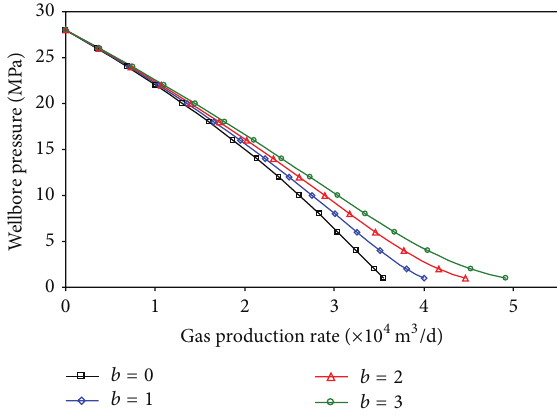
Figure 7: Effect of fracture half-length 𝐿 𝑓 on productivity.